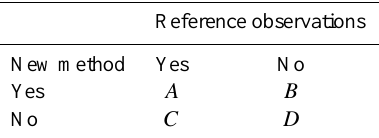
Table 1. Contingency table used to evaluate drizzle delineation methods. A–D represent the number of hits, false alarms, misses and correct negatives,